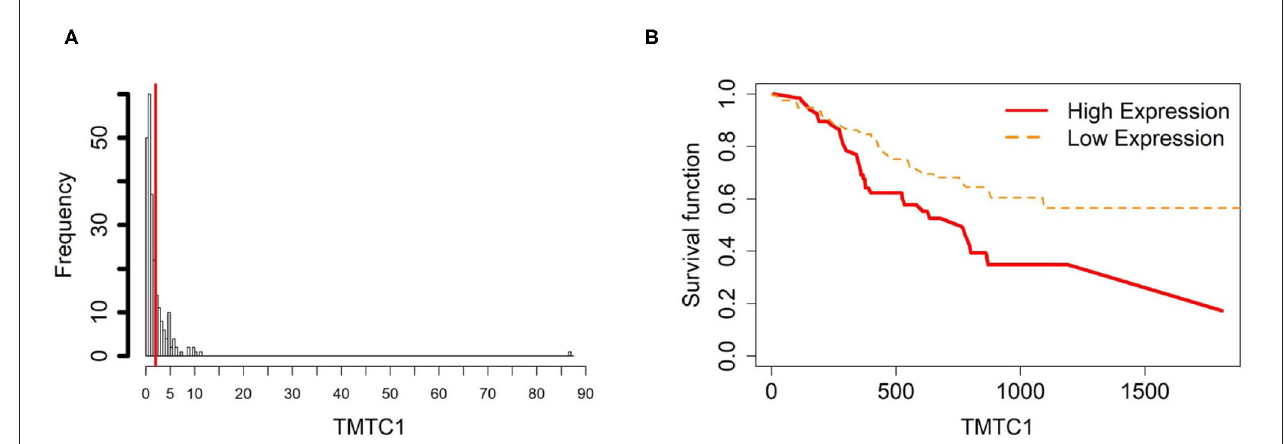
FIGURE 6 | Survival analysis in TMTC1. (A) Depicts the histogram of TMTC1 gene expression. Based on the TMTC1 data from TCGA-STAD, we set 2 as the gene expression threshold to separate the 238 observations into two groups: low expression and high expression groups of samples. (B) Shows the estimated survival function plots using a Cox proportional hazard regression analysis between the two groups; FDR p -value between the two groups.